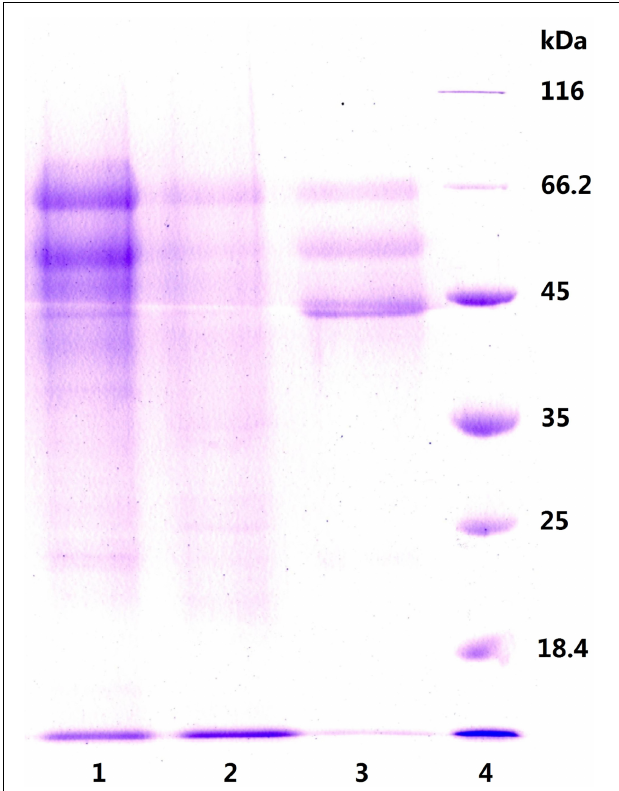
FIGURE 3 | SDS-PAGE analysis of P55 and P70. Lane 1: P70, precipitate at ethanol 70% (v/v); Lane 2: P55, precipitate at ethanol 55% (v/v); Lane 3: natural inulinase of Aspergillus niger ; Lane 4: